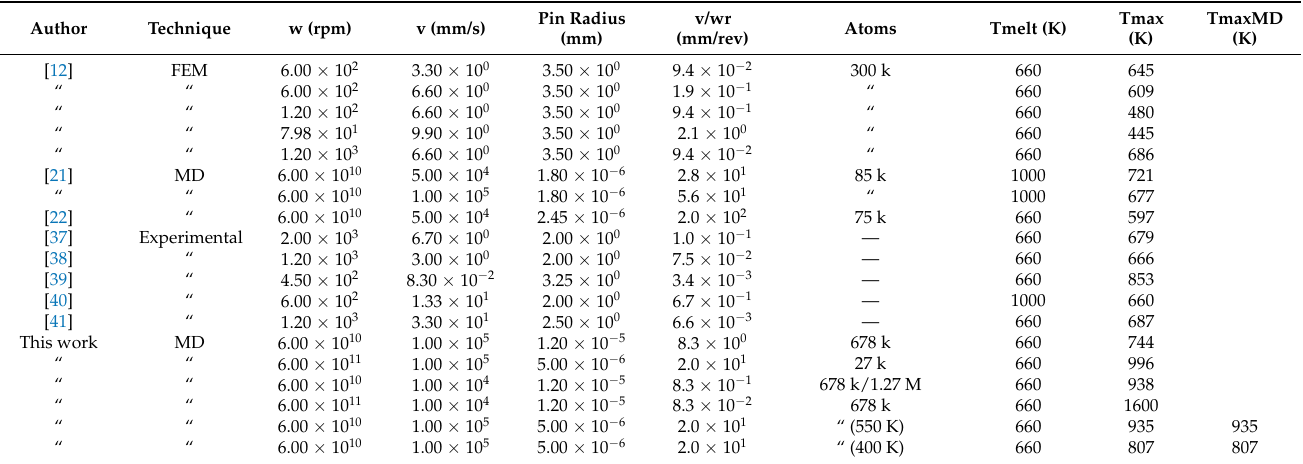
Table 1. Molecular dynamics, FEM and experimental FSW parameters, and Tmax calculated for aluminum and copper.